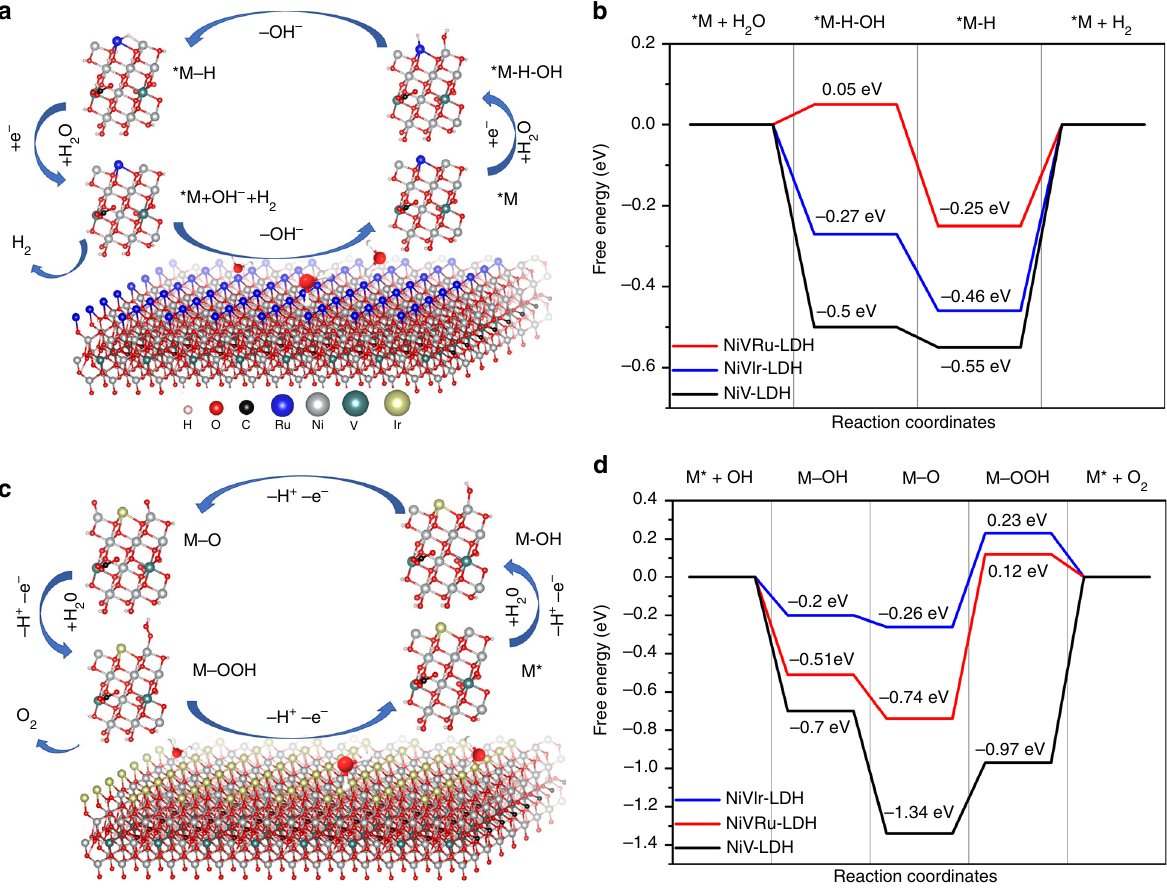
Fig. 7 DFT calculations. a The atomic model of NiVRu-LDH and the proposed HER pathway. b The free energy diagram of HER on the NiV-LDH, NiVRu- LDH, and NiVIr-LDH catalysts. c The atomic model of NiVIr-LDH and the proposed OER pathway. d The free energy diagram of OER on the NiV-LDH, NiVRu-LDH, and NiVIr-LDH